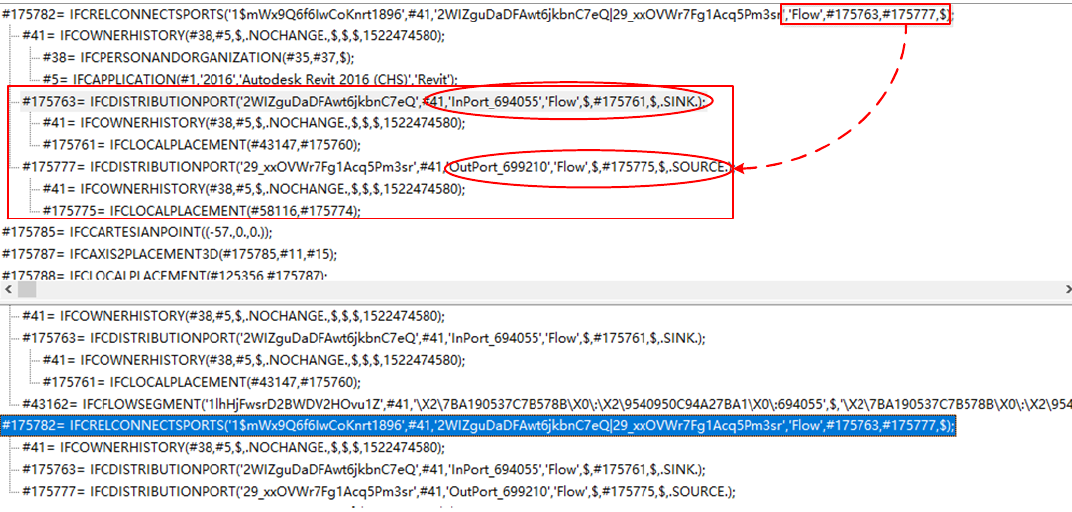
Figure 14. Example of the upstream and downstream relationship.